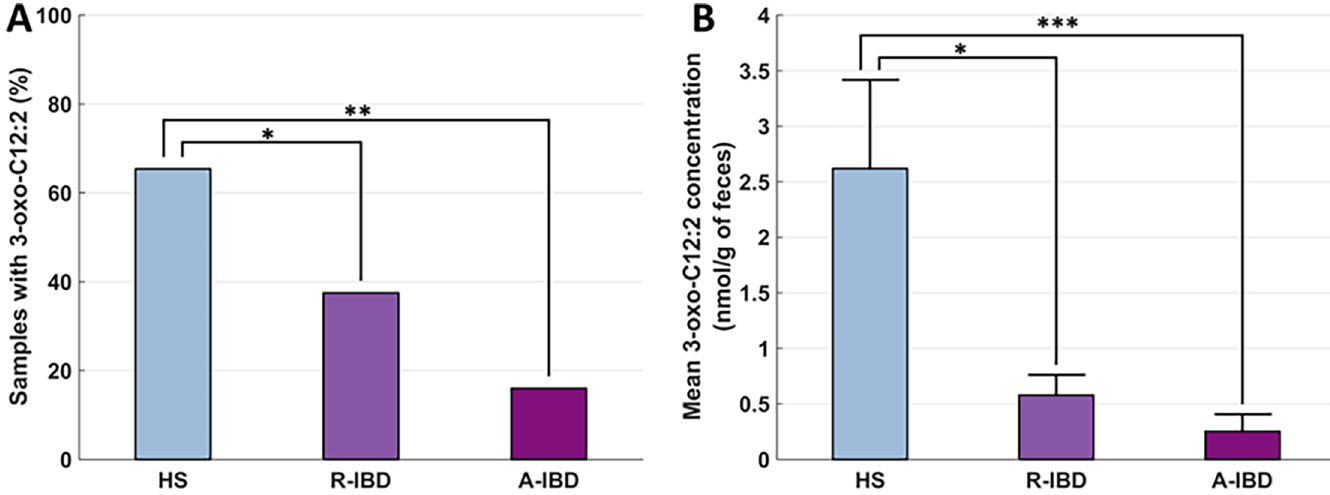
Fig 3. Bar graph of AHL 3-oxo-C12:2 distribution and concentration among healthy subjects (HS) and IBD in remission (R-IBD) and in flare (A-IBD). A: proportion of samples with AHL 3-oxo-C12:2. B: mean 3-oxo-C12:2 faecal concentration. (cid:3) p < 0.05 (cid:3)(cid:3) p < 0.005 (cid:3)(cid:3)(cid:3) p < 0.0005.